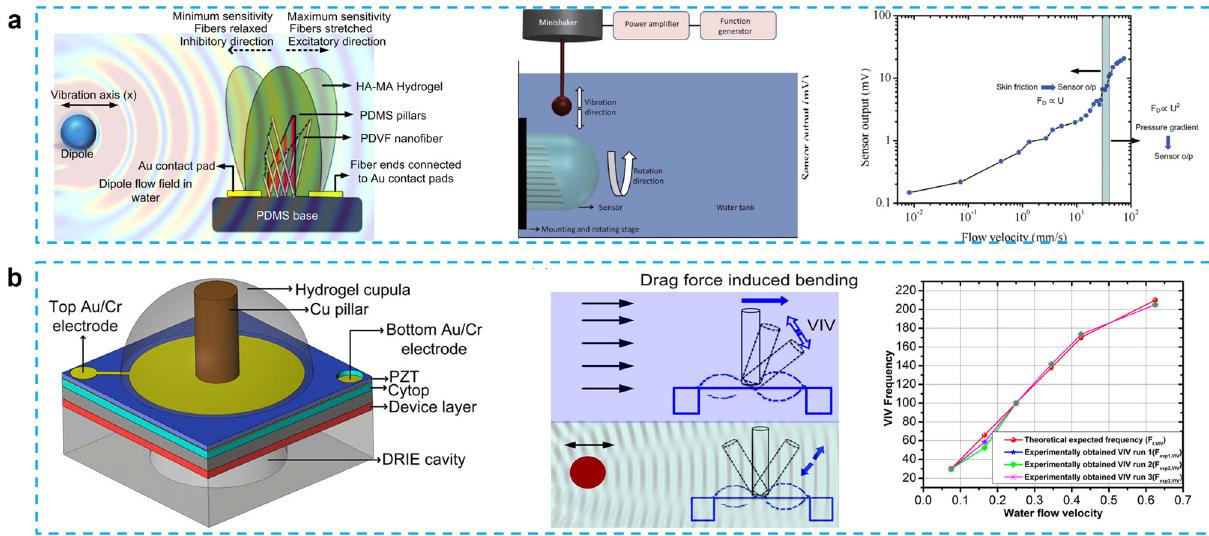
Figure 3. ( a ) From biological cilia to artificial flow sensors: biomimetic soft polymer nanosensors with high sensing performance: a schematic showing the flow sensing mechanism in the presence of an oscillating dipole, schematic showing the basic experimental setup used in all the experiments, and sensitivity and threshold-detection limit of the sensors over a range of velocities. (Reprinted with permission from Ref. [62], Copyright 2016, Springer Nature.) ( b ) Fish-inspired self-powered microelectromechanical flow sensor with biomimetic hydrogel cupula: biomimetic flow sensor with an artificial cupula, schematic showing sensing mechanism of steady-state and oscillatory flow stimuli, steady-state flow sensing using flow-generated VIV. (Reprinted with permission from Ref. [43], Copyright 2017,